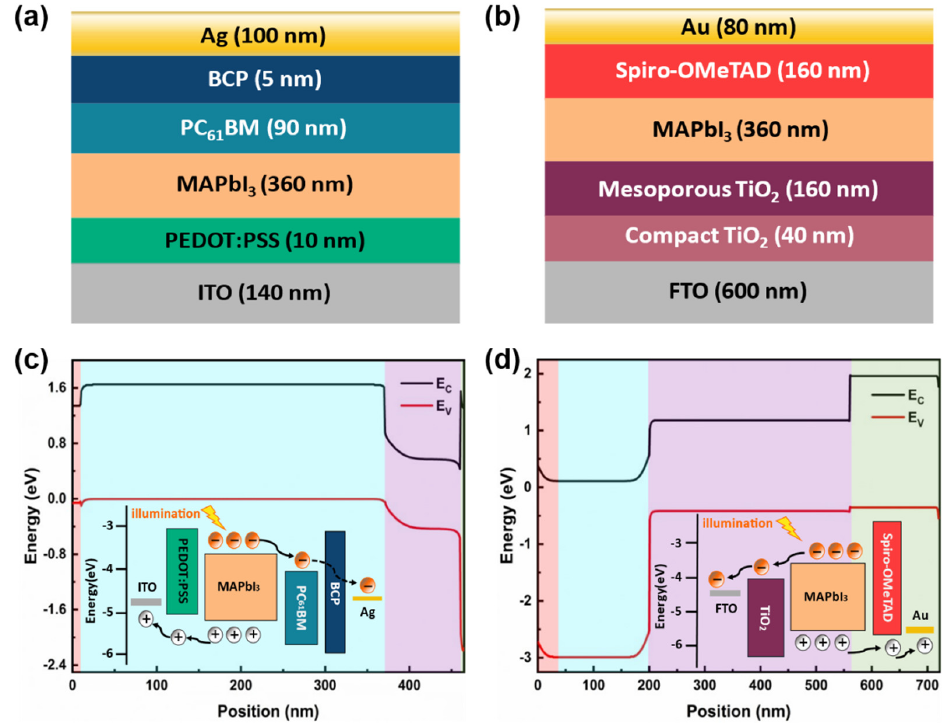
Figure 1. The structural schematic of both ( a ) inverted and ( b ) regular perovskite photodiodes and the diagrams of energy bands and the process of carrier generation, separation, and transport of ( c ) the inverted and ( d ) regular perovskite photodiodes. ( c ) the inverted and ( d ) regular perovskite